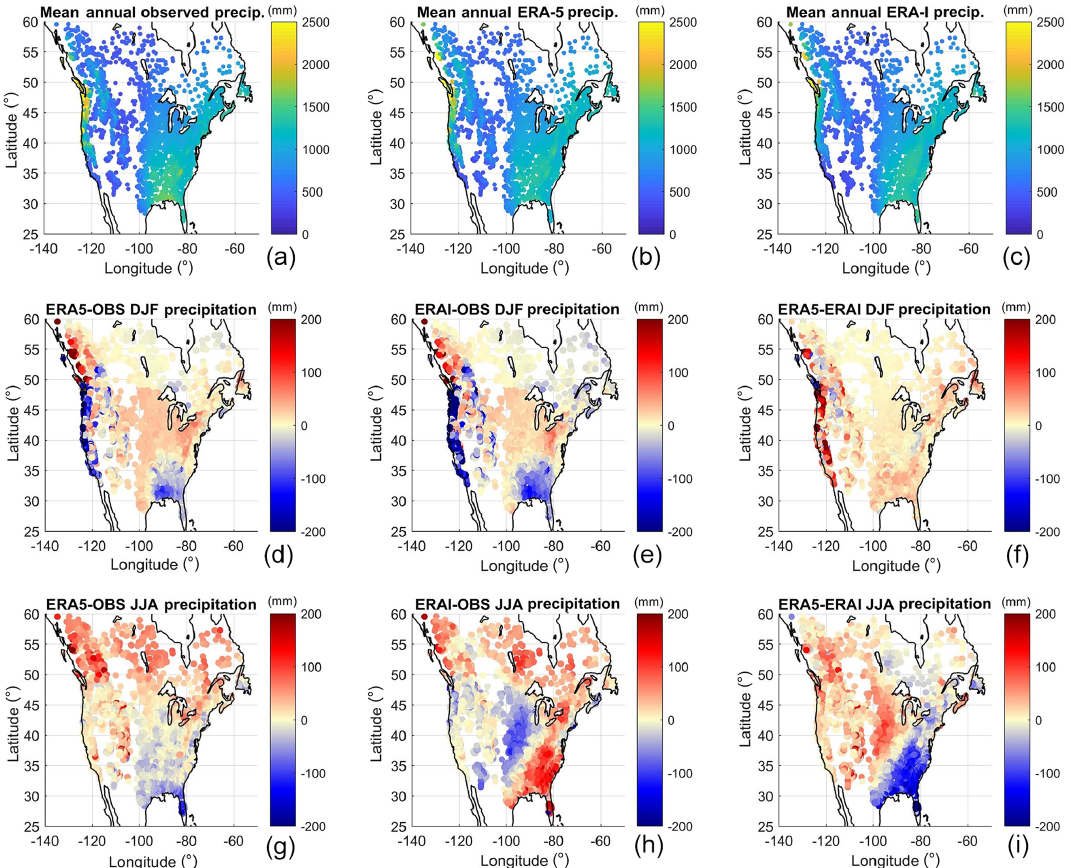
Figure 3. Mean annual precipitation for all three datasets (a, b, c) and seasonal differences (winter in d, e, f , summer in g, h, i ). All values are in mmyr − 1 .